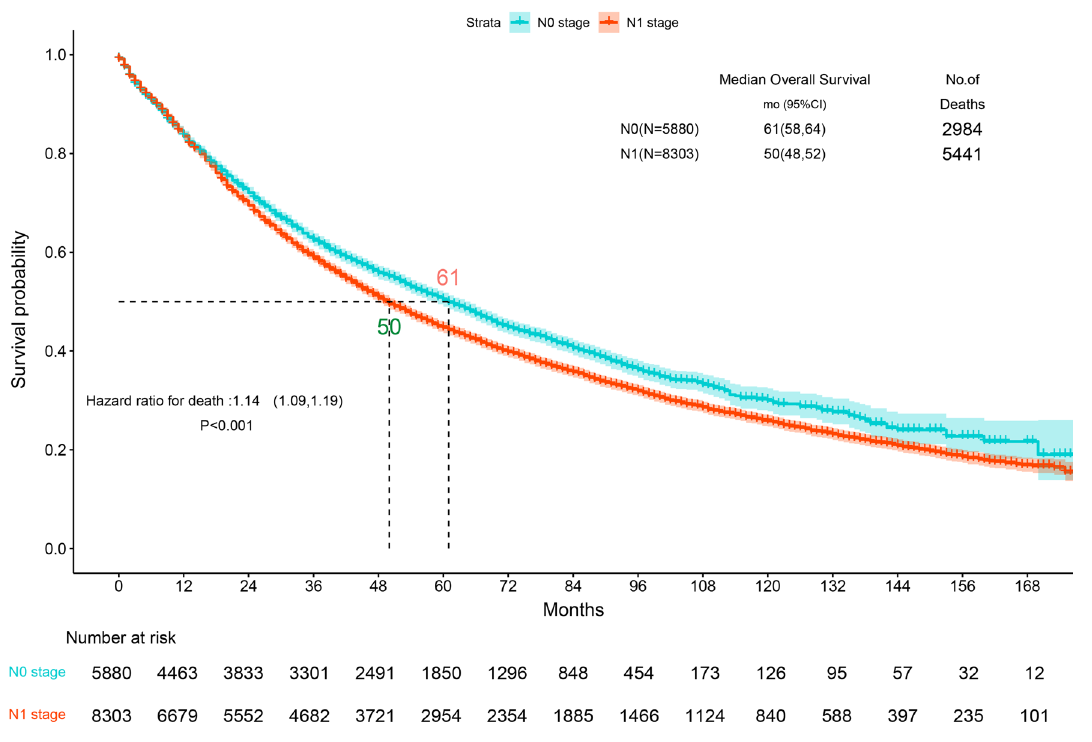
Fig. 2 Kaplan–Meier survival curves for stage N0 patients versus stage N1 patients